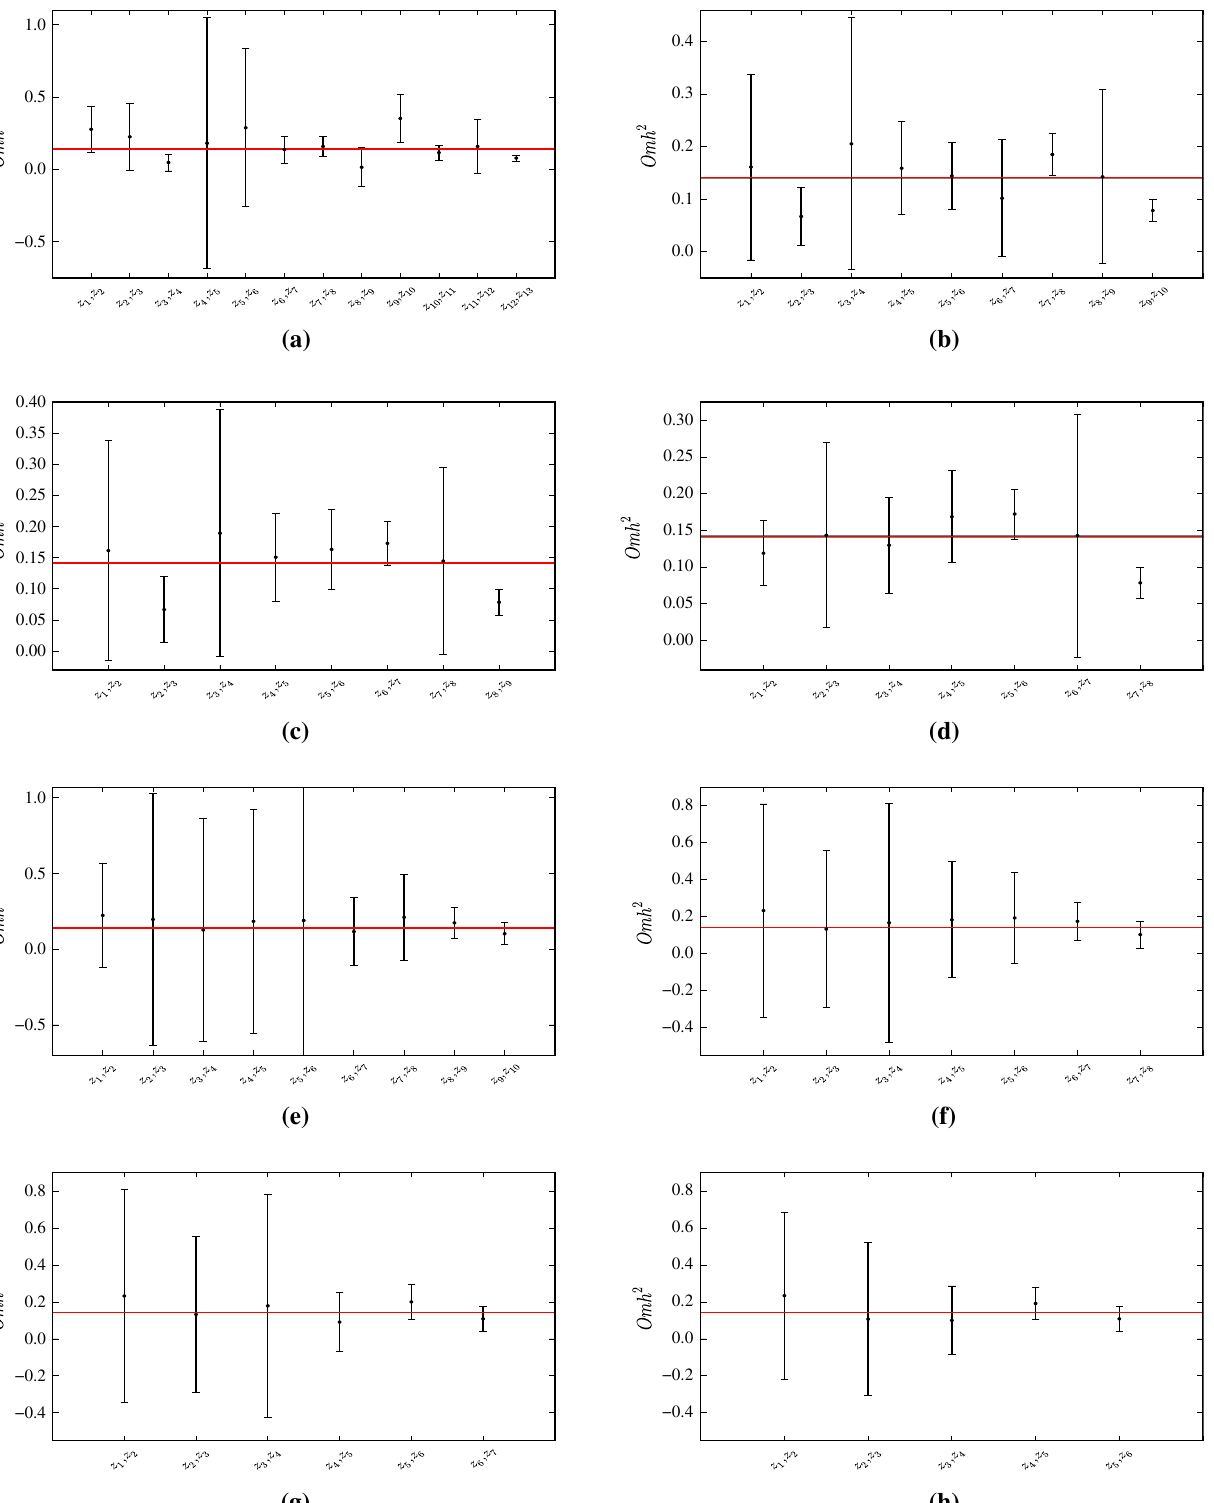
Fig. 4 Omh 2 diagnostic values for both the weighted mean and median statistics techniques with respect to continuous redshifts. The panels a – d present the weighted mean 3–4, 4–5, 5–6, and 5–6–7 mea- surements per bin, respectively. The panels e – h present the median